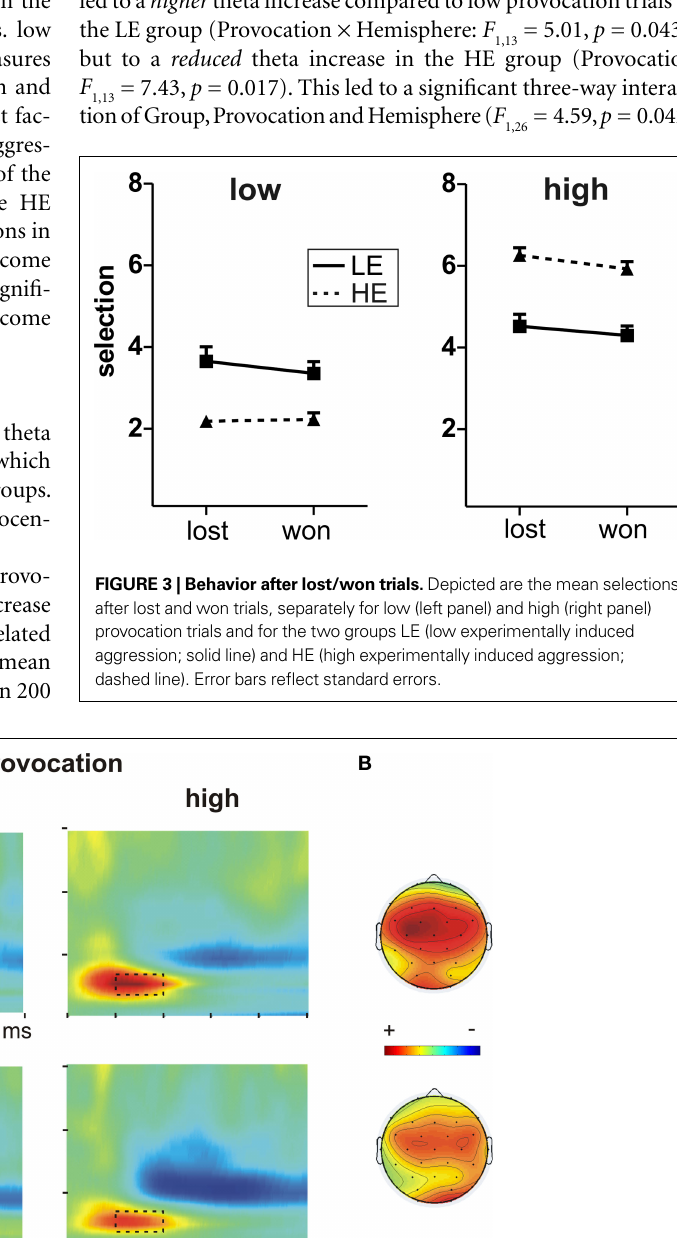
FIGURE 4 | Time frequency results decision phase. (A) Changes in power (%) relative to the baseline (100 ms before the decision phase) in low (left panel) and high (right panel) provocation trials at the left frontal electrode F3, separately for the LE (low experimentally induced aggression; upper row) and HE (high experimentally induced aggression; lower row) groups. Highlighted is the